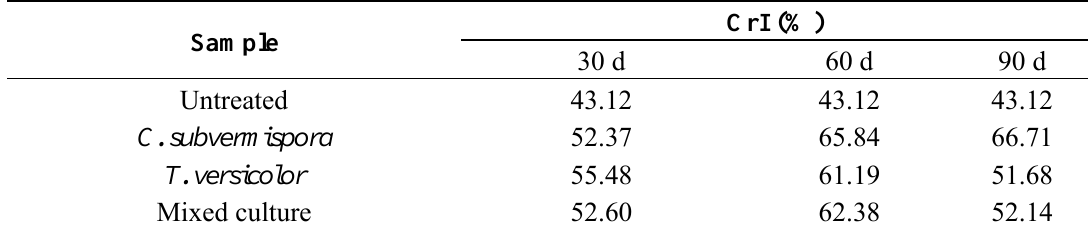
Table 2. Crystallinity index of untreated and fungal-treated rubberwood after 30, 60, and 90